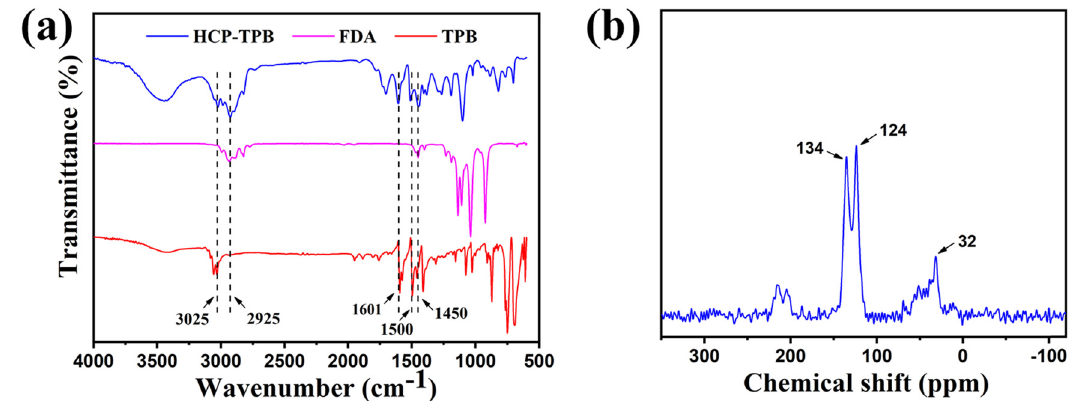
Figure 2: ( a ) FT - IR spectra of TPB, FDA, and HCP - TPB; ( b ) 13 C CP/MAS NMR spectrum of HCP -